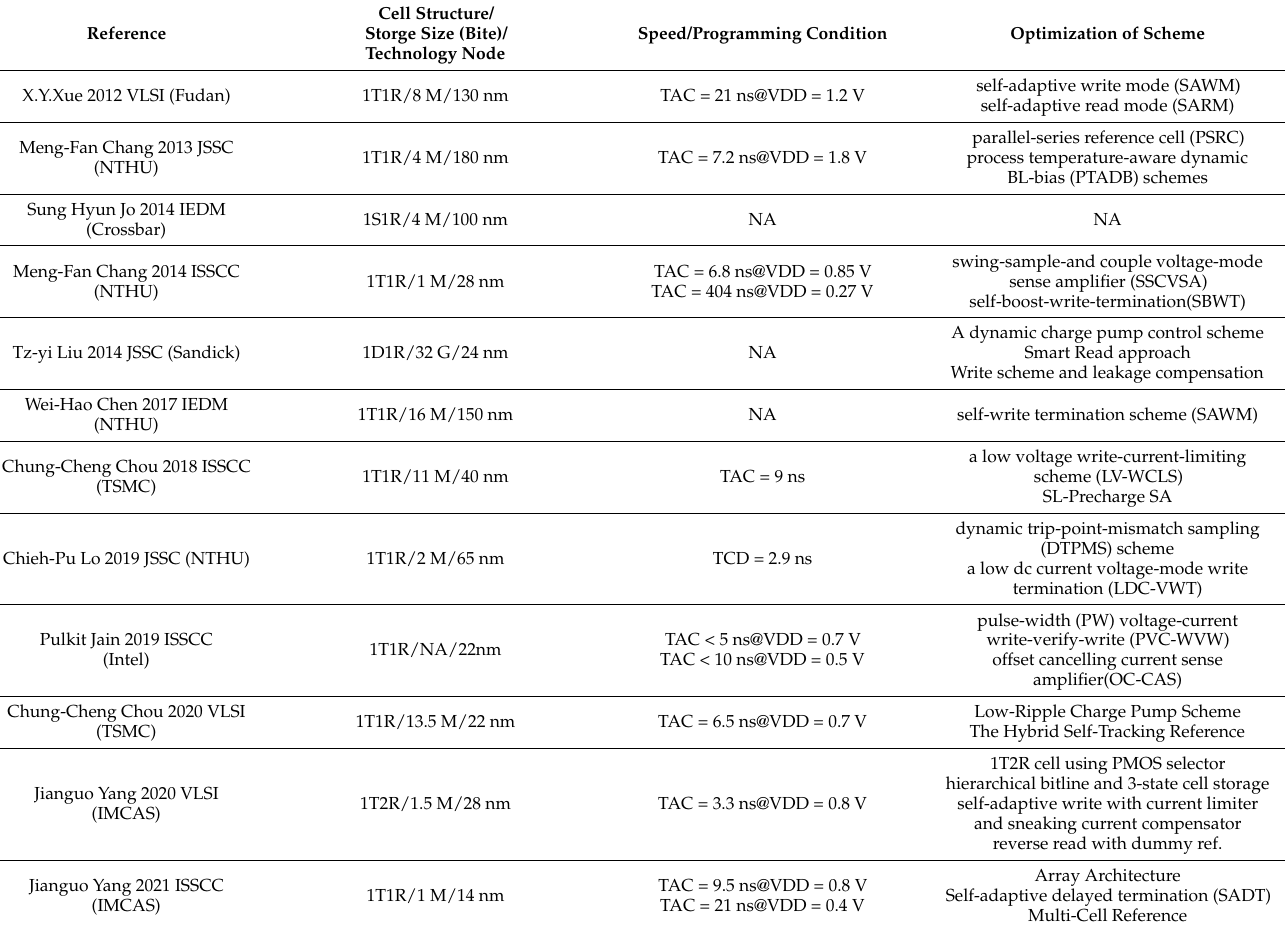
Table 1. Published articles on RRAM’s periphery schemes since 2012. The first column lists the first author, publishing year, and journal abbreviation, together with the first affiliation shown in the